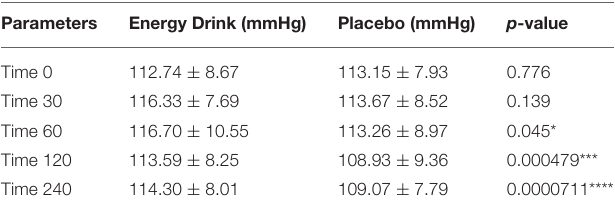
TABLE 3 | The separate effect of beverage and time on systolic blood pressure ( n = 27).